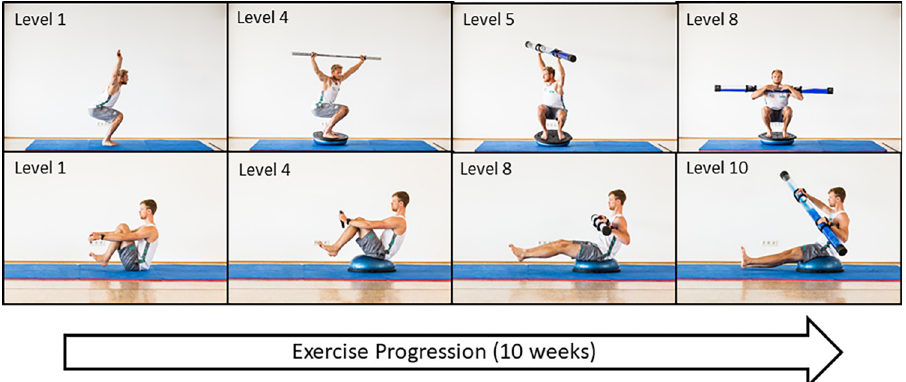
Fig 2. Progression of the basic exercises squat (upper line) and rowing (lower